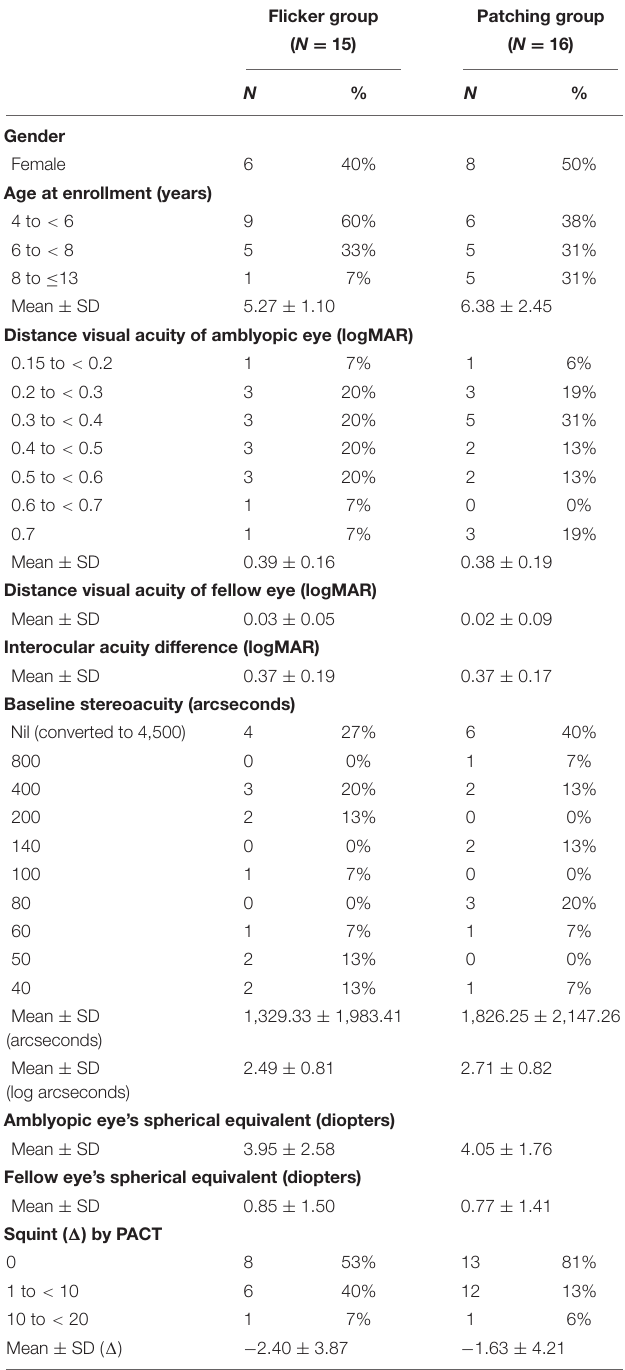
TABLE 1 | Baseline characteristics of the patients. Flicker group Patching